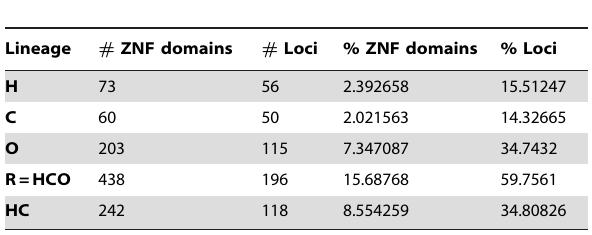
Table 3. Numbers of ZNF domains with species-specific sequence